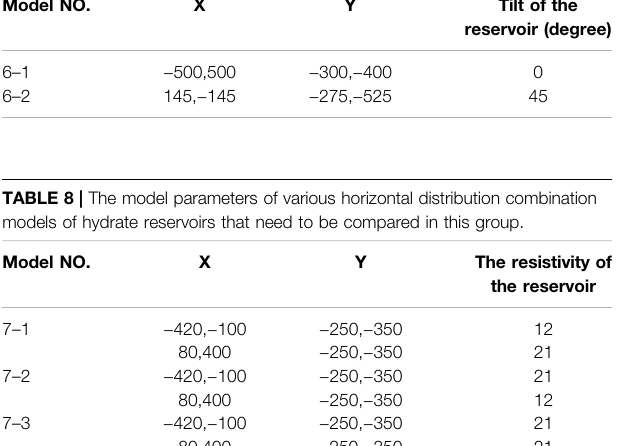
TABLE7| Themodelparametersofvariousdipsofthehydratereservoirthatneed to be compared in this group. Model